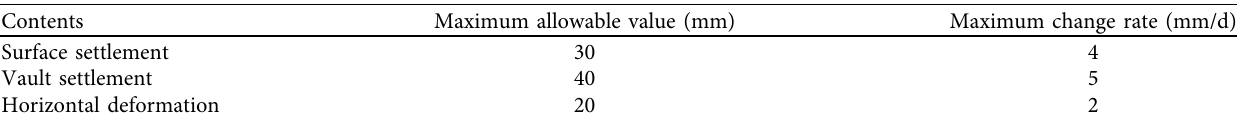
Figure 15: Layout of monitoring points. Table 2: Maximum allowable values [13, 24, 33].